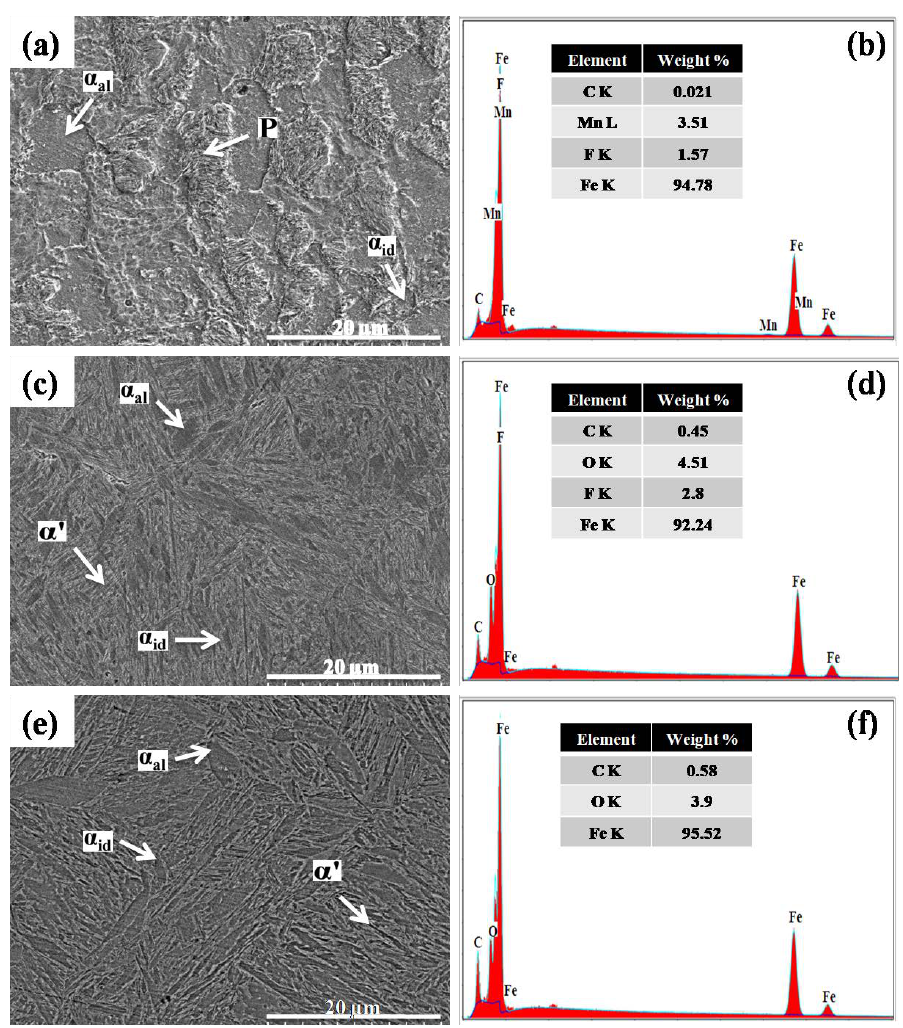
Figure 1. SEM images and EDS spectra of ( a , b ) as-received, ( c , d ) water quench-hardened, and ( e , f ) brine (10 wt% NaCl) quench-hardened low-carbon